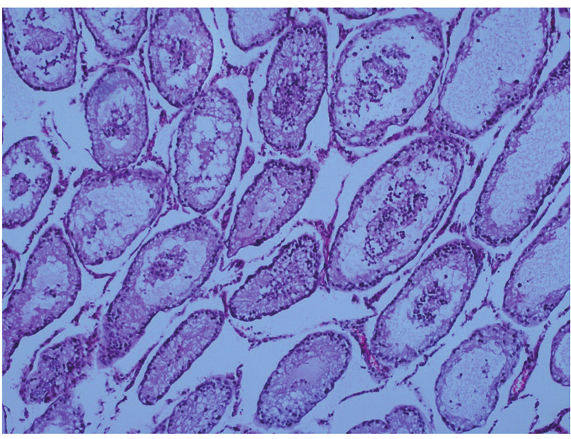
figure 2 - Histopathology image of the testis parenchyma obtained from the alprostadil group (Group 5) (cosentino Grade 3).